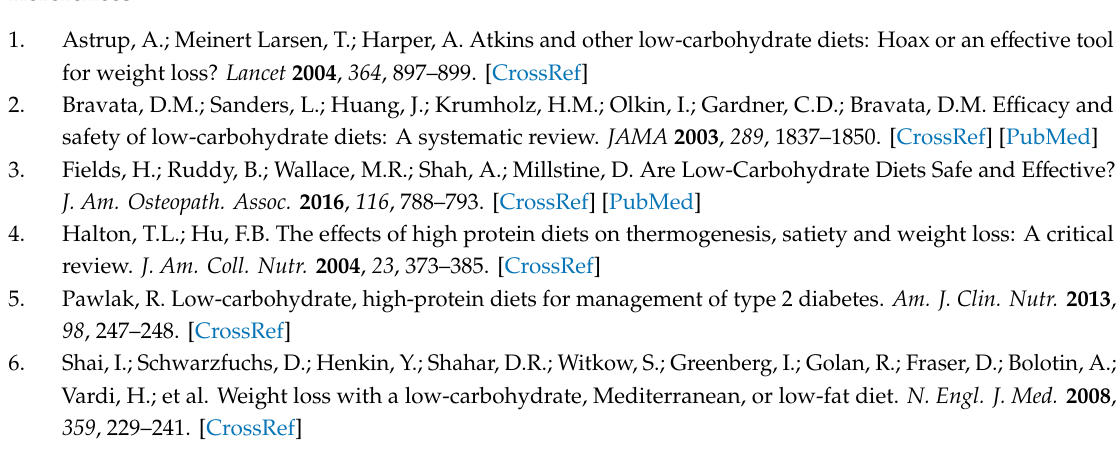
Table S1: Composition of the experimental